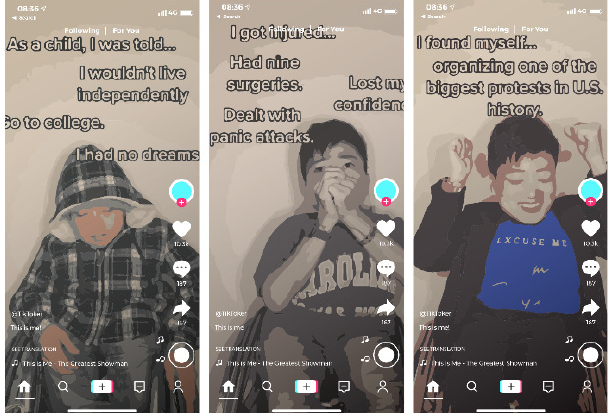
Figure 7. Illustrated TikTok post about ableism and capability.